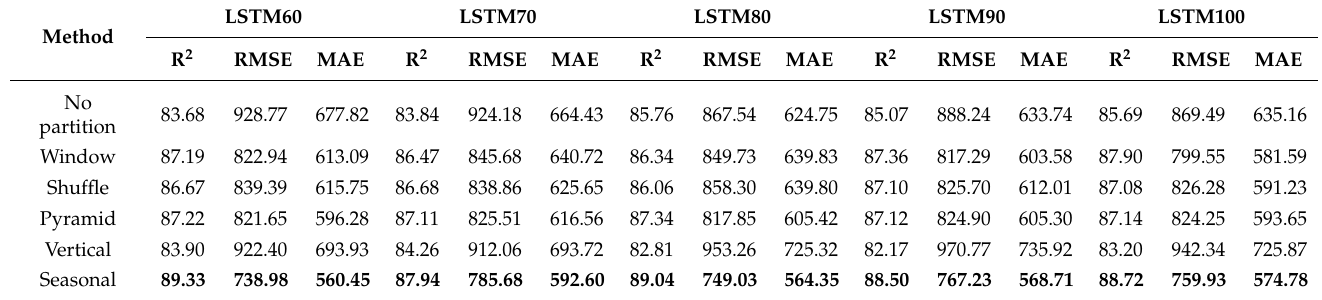
Table 9. Experimental results of daily forecasting of Site B.